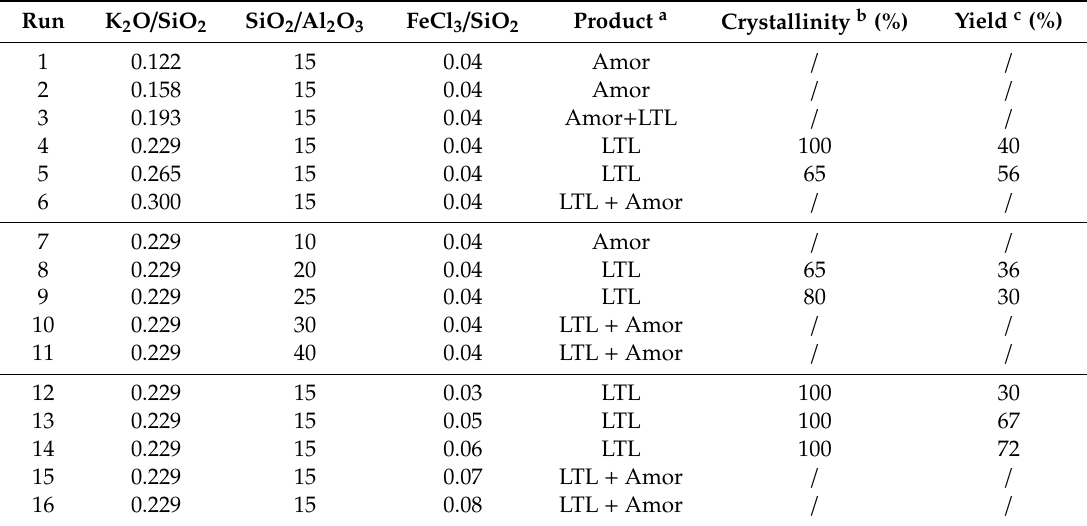
Impact of synthesis conditions on crystallization of Fe-LTL zeolite